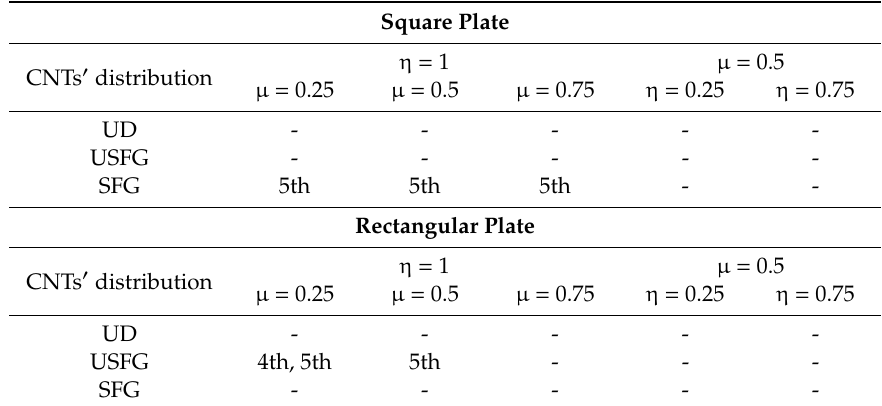
Table 21. Summary of the agglomeration e ff ect in the natural modes (cid:48) shapes of the quadrilateral plates. Square Plate η = 1 µ = 0.5 CNTs (cid:48) distribution µ = 0.25 µ = 0.5 µ = 0.75 η = 0.25 η = 0.75 UD - - - - - USFG - - - - - SFG 5th 5th 5th - - Rectangular Plate η = 1 µ = 0.5 CNTs (cid:48) distribution µ = 0.25 µ = 0.5 µ = 0.75 η = 0.25 η = 0.75 UD - - - - - USFG 4th, 5th 5th - - - SFG - - - -